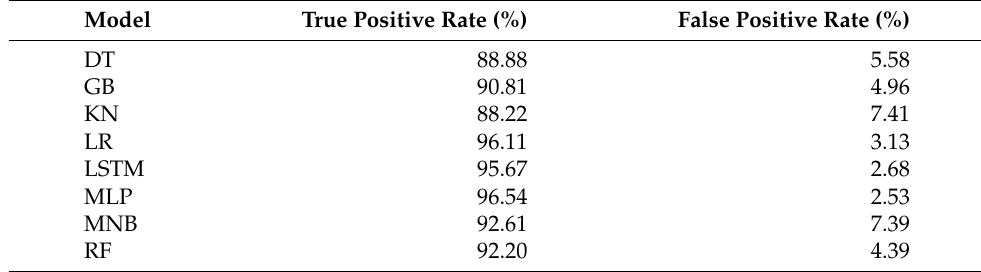
Table 10. Optimum true positive and false positive